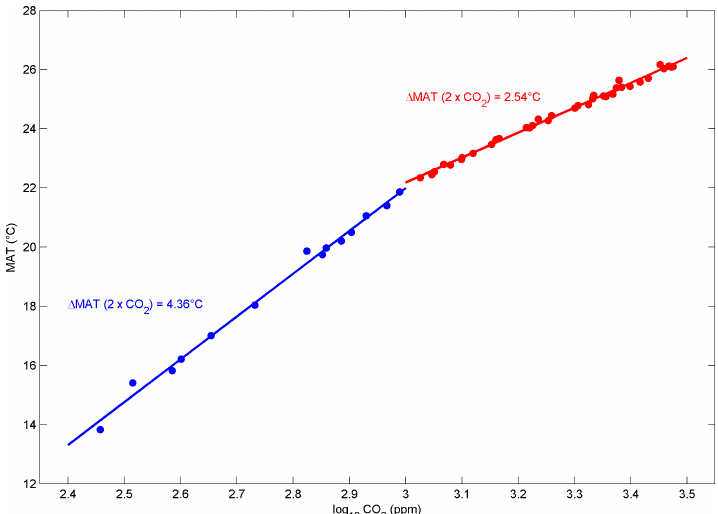
Figure 7. Mean air temperature plotted against CO 2 on a logarithmic scale, with regression lines plotted for CO 2 <1000ppm (blue) and CO 2 >1000ppm (red), with climate sensitivities for a doubling of CO 2 from both of the regressions.